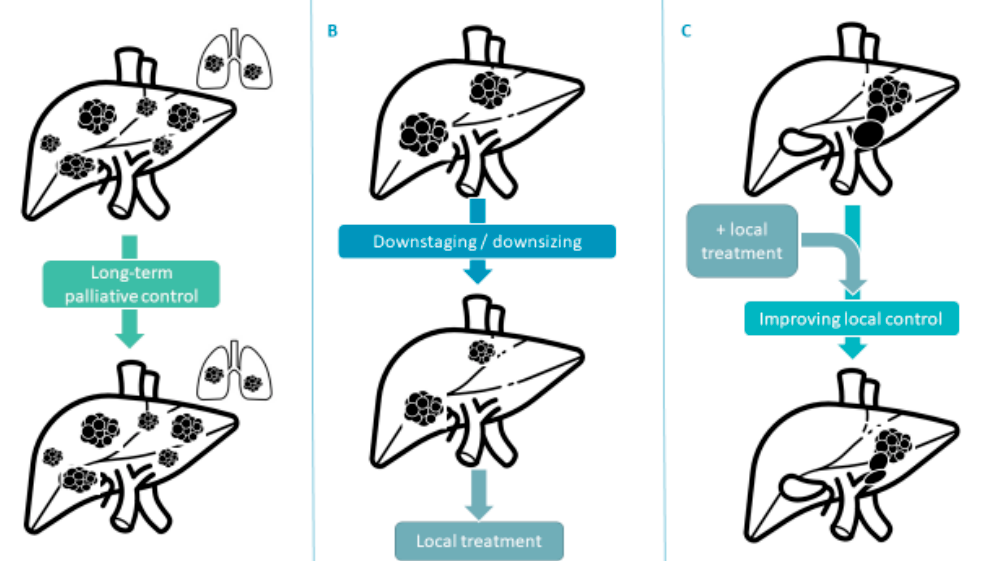
Figure 2. Potential emerging strategies for use of systemic therapies in unresectable HCC: ( A )—long-term palliative control, ( B )—downstaging to local treatment (resection, transplantation, percutaneous destruction, transarterial treatment, …), and ( C )—combination with local treatment for improved local control.